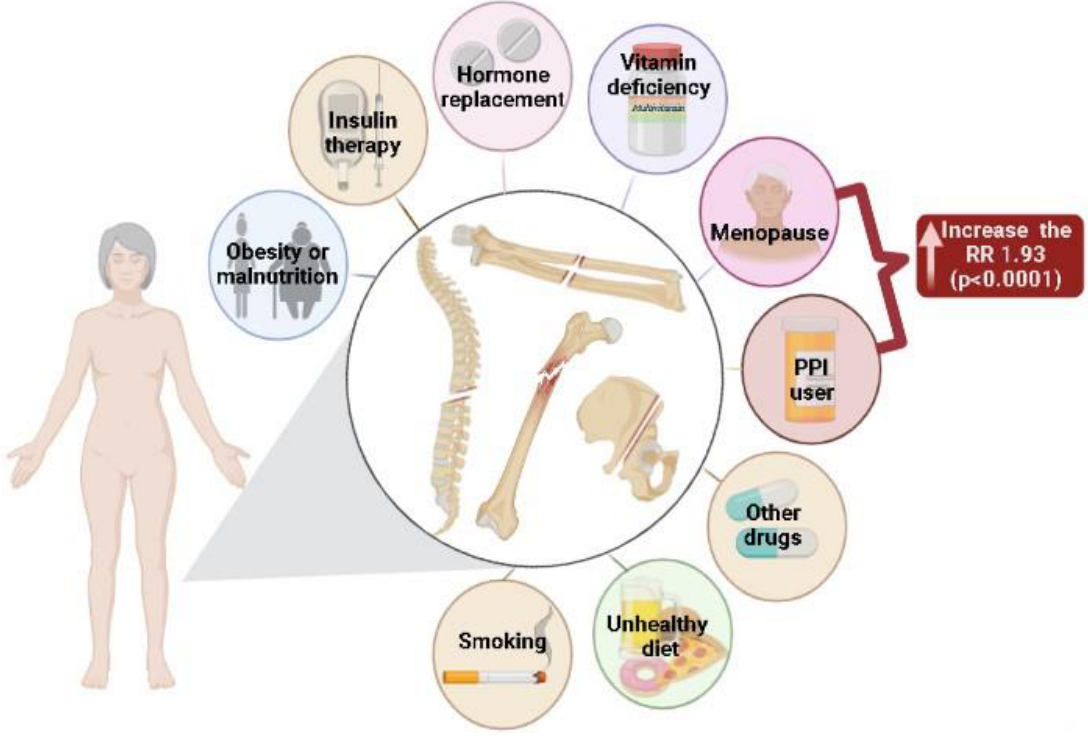
Figure 3. Risk factors for fractures in women.